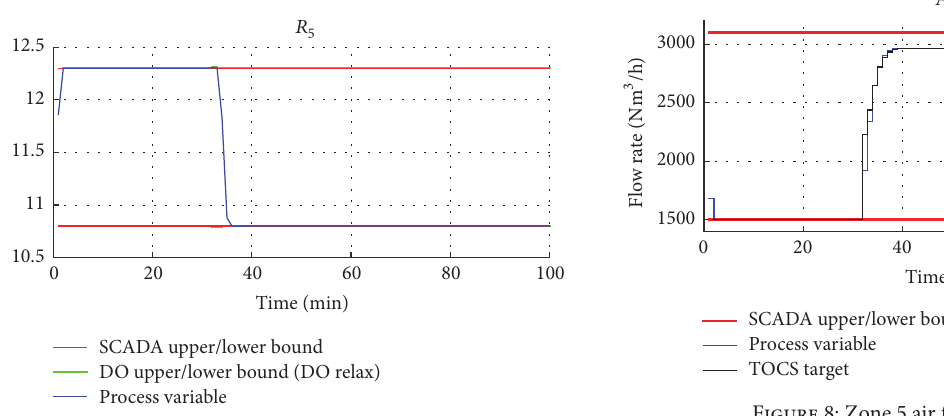
Figure 6: Zone 5 stoic. ratio trends.